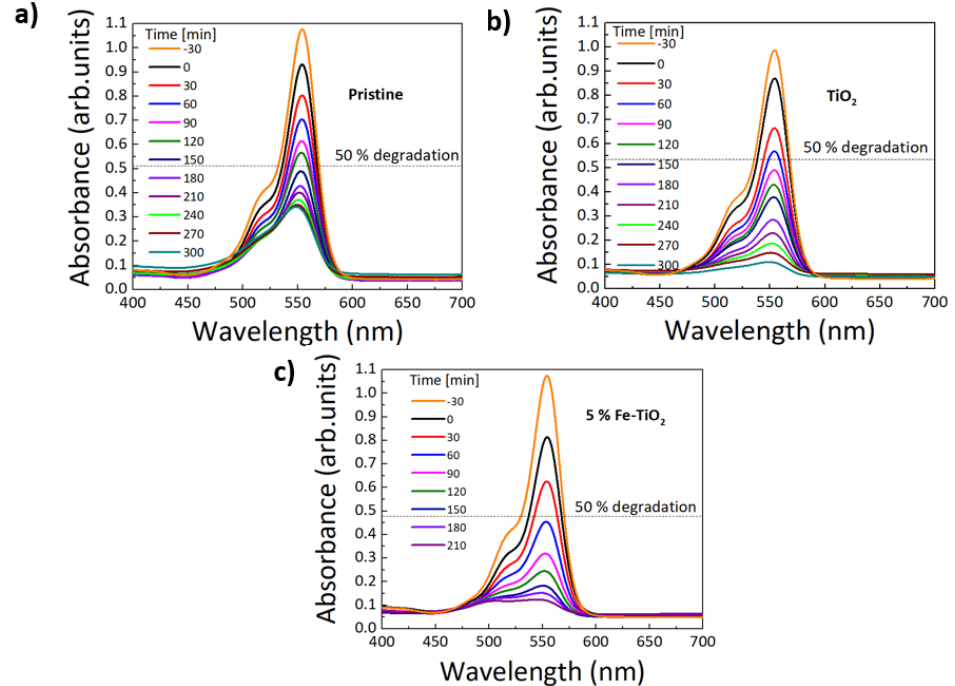
Figure 10. RhB absorbance spectra under simulated solar light radiation (LED simulator with AM 1.5 spectrum) up to 5 h for the polymeric substrates ( a ) without nanopowders, ( b ) with pure TiO 2 , and ( c ) with 5 mol% of Fe ‐ TiO 2 nanopowders with the addition of PEG.